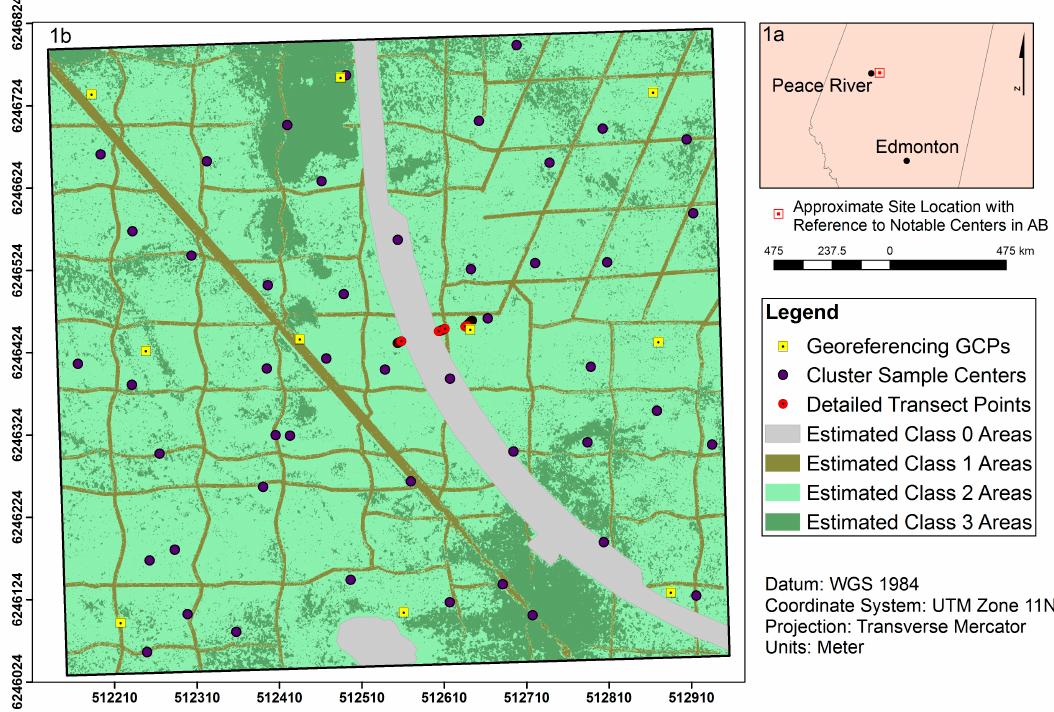
Figure 1. Approximate site location in the province of Alberta (AB) with reference to nearby notable city centers ( 1a ); Estimated distribution of surface complexity classes across the study site ( 1b ). An extensive network of linear disturbances transect the site. Areas between these features are assumed to be undisturbed and indicative of natural boreal treed bog conditions within the region. GCP installation locations, cluster sample and detailed transect points are shown ( 1b ), and described in Section 2.2.1.